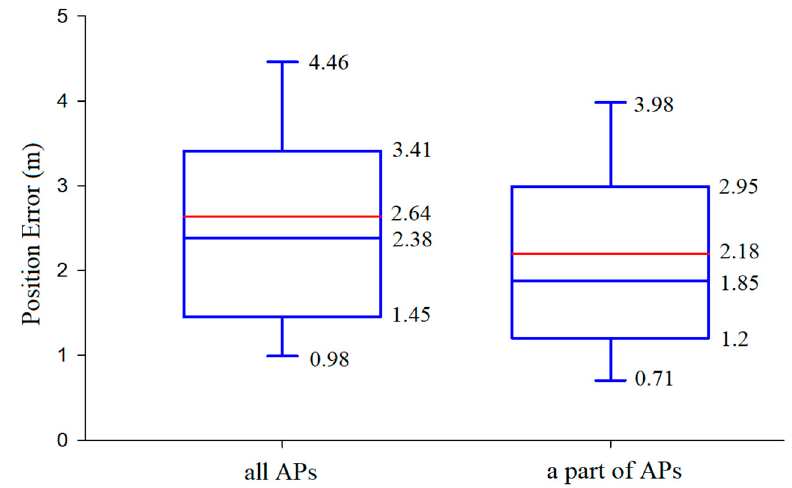
Figure 5. Comparison of the positioning performance shown in boxplots.